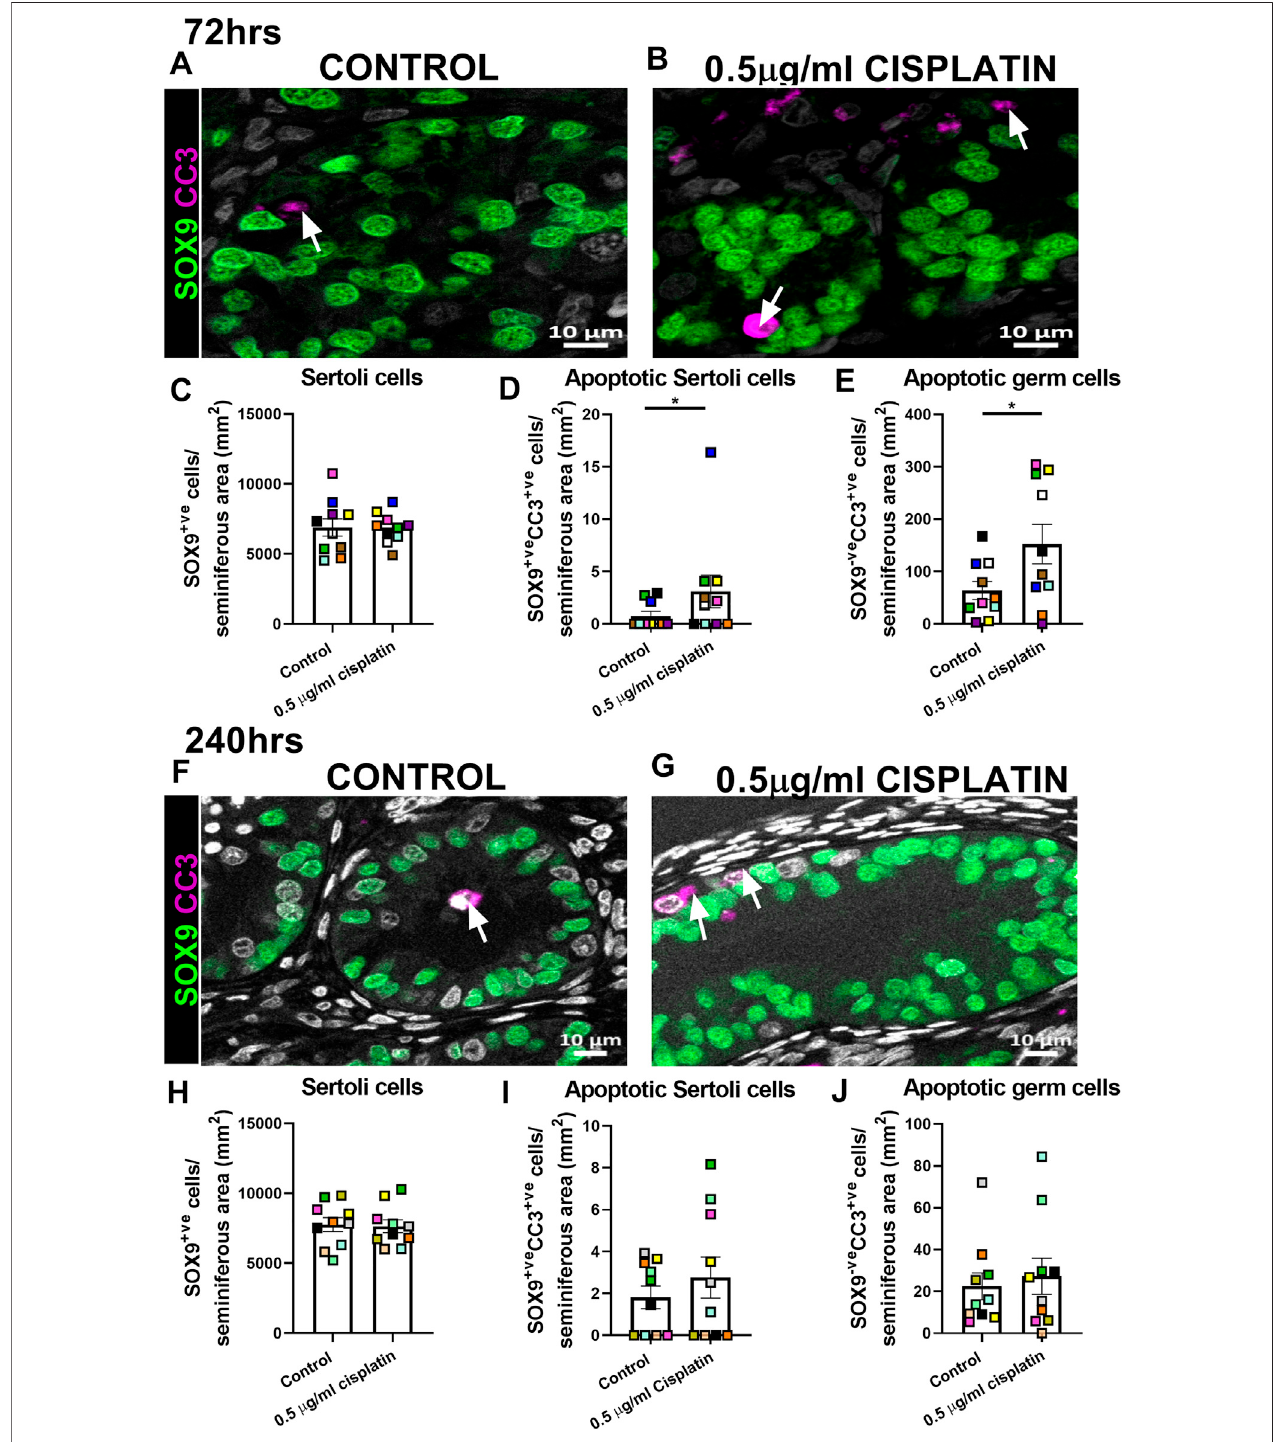
FIGURE2| IntermediateandprolongedeffectsofexposuretocisplatinonSertolicellnumberandapoptosiswithincordsinthehumanfetaltesticulartissues.SOX9 (green) and cleaved caspase 3 (CC3; purple) protein expression in the human fetal testicular tissues 72 h (A,B) and 240 h (F,G) following exposure to vehicle control or cisplatin (0.5 μ g/ml). Scale bars represent 10 μ m, arrows point to apoptotic germ cells (SOX9 − ve CC3 +ve ). Quanti fi cation of Sertoli cell (SOX9 +ve ; C&H), apoptotic Sertoli cell (SOX9 +ve CC3 +ve ; D&I) and apoptotic germ cell (SOX9 − ve CC3 +ve ; E&J) numbers per cord area (mm 2 ) in the human fetal testicular tissues 72 h (C – E) and 240 h (H – J) following exposure to vehicle control or cisplatin (0.5 μ g/ml). Sertoli cell numbers were unaffected at either 72or 240 h post-exposure to 0.5 μ g/ml cisplatin. Signi fi cantincreaseinapoptoticSertoliandapoptoticgermcellnumberswasobservedat72 hbutnot240 hpost-exposure.Dataanalysedusingtwo-wayANOVA(* p < 0.05). Values shown are means ± SEM and each set of coloured data points represents an individual fetus ( n = 10).